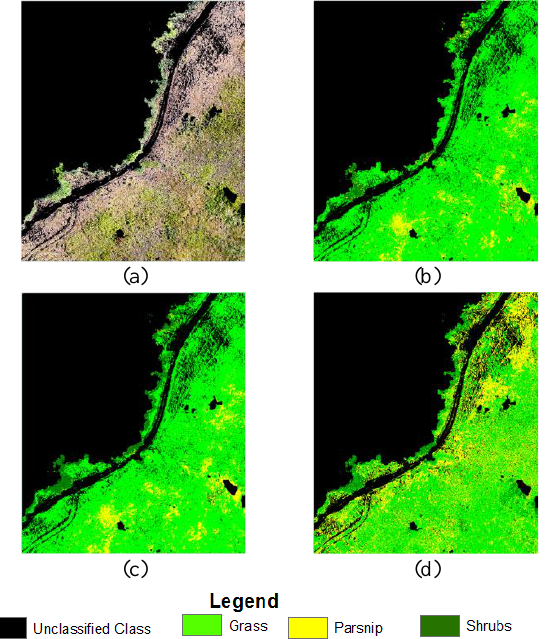
Figure 7 . Object-based classification result: (a) UAV Masked Image (0.02 m resolution), (b) RF, (c) SVM, (d)